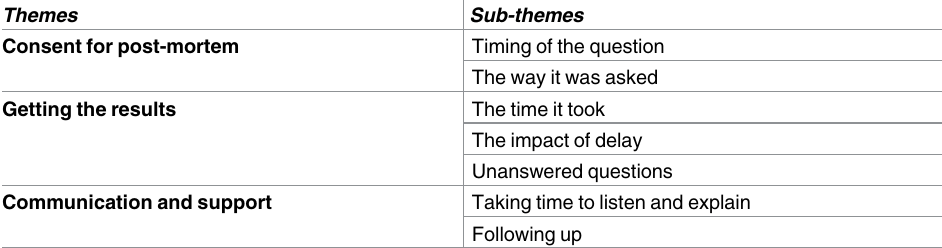
Table 8. Themes identified in qualitative analysis of open text